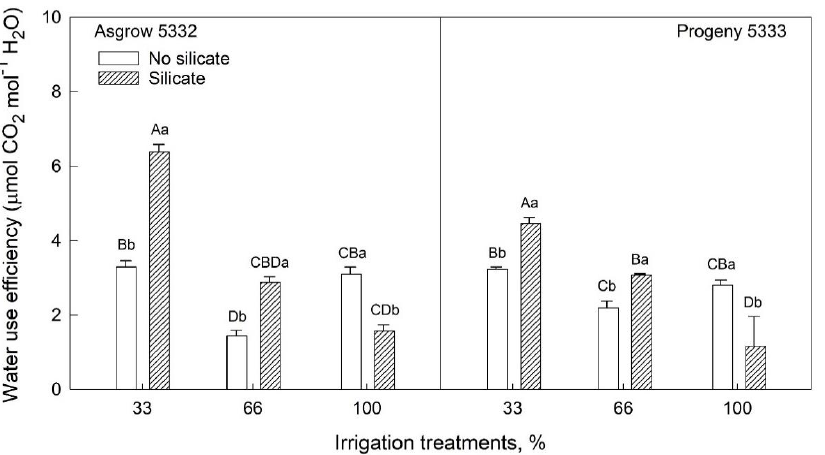
Figure 7. The influence of silicate application on two soybean cultivars’ water-use efficiency across three irrigation treatments, measured at 45 days after emergence of the seedling. The values are mean and standard errors of five replications in each treatment. The error bars correspond to standard error. The bars followed by the same letters (lower-case letters within silicate and no silicate and upper-case letters within irrigation and silicate treatments) did not differ significantly at 5% by Tukey’s test.